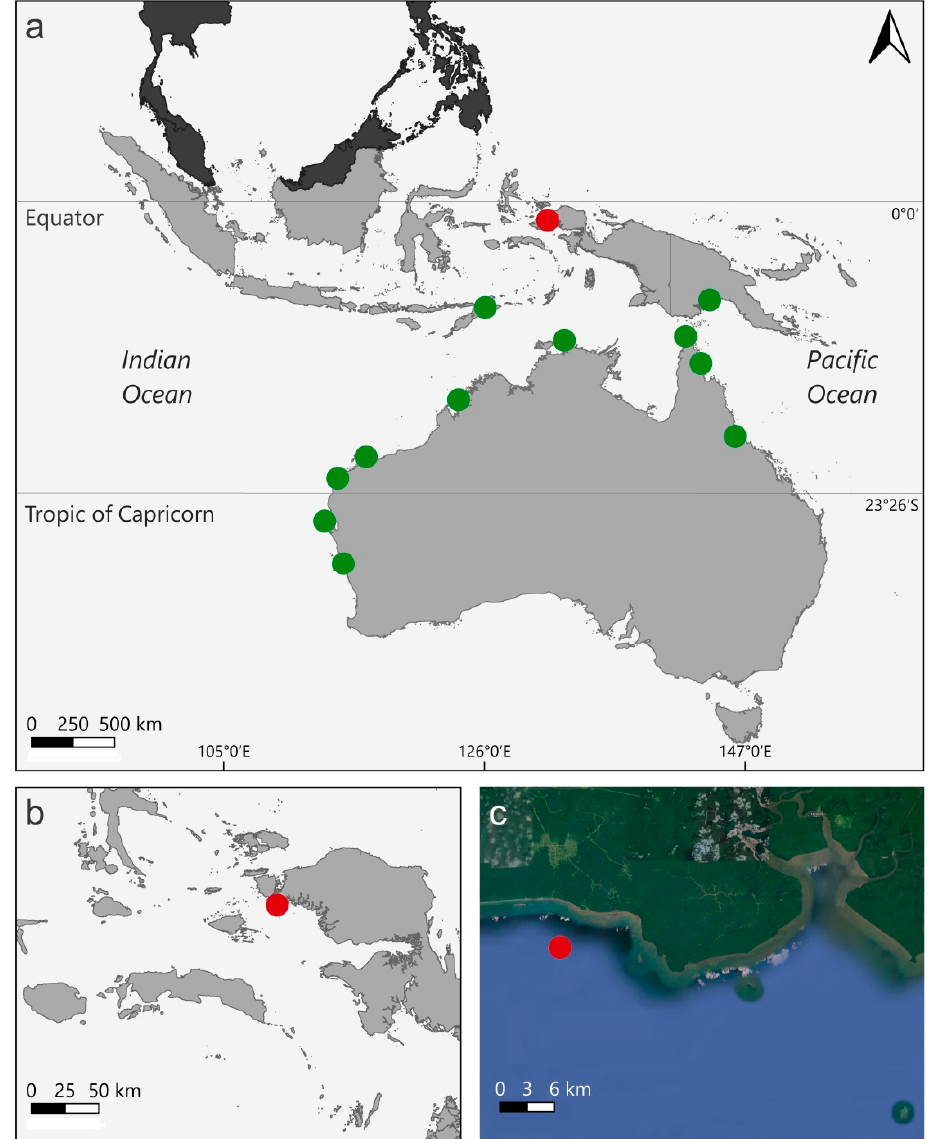
Figure 1. ( a ) Published distribution records of Duncanopsammia axifuga from Australia, New Guinea, and East Timor ( green dots ) [5,6]; and a new record from Bird’s Head Peninsula, Indonesia ( red dot ). ( b ) A detailed map of Bird’s Head Peninsula and adjacent waters. ( c ) Satellite imagery of the observation location at Seget District, West Papua, Indonesia, showing the muddy coastline (Source: Google Maps; Imagery ©2022 TerraMetric. Map data ©2022).